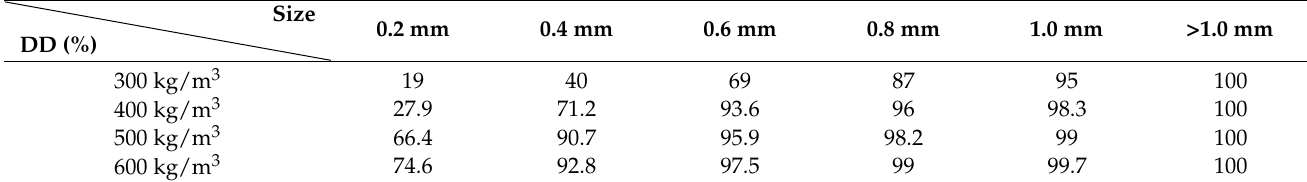
Table 4. Cumulative distribution of the apertures with different dry densities.